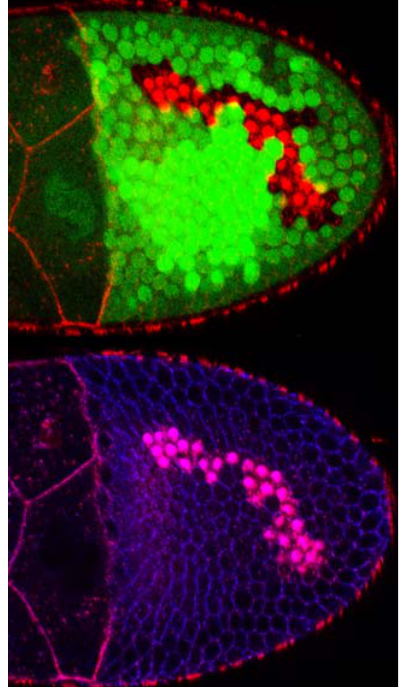
DOI: 10.1371/journal.pbio.0020100.g001 Figure1. CAP Mutant Clones Follicle cells lacking CAP accumulate actin (red) in their apical region. Ena (blue in the bottom panel), also accumulates apically in the mutant cells (looks pink in the clone of cells due to overlap with F-actin in red). The mutant cell clones are identifi ed by the absence of GFP (green in the top panel). Using this technique the cytoskeleton of mutant cells can be analysed in the context of a wild type epithelium. (Image kindly supplied by Buzz